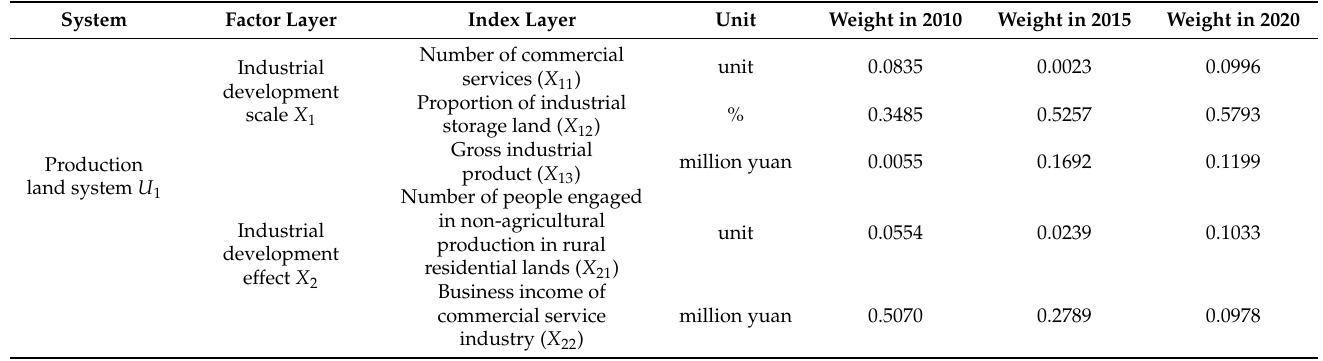
Table 4. Evaluation index and its weight of production land and living land in a rural